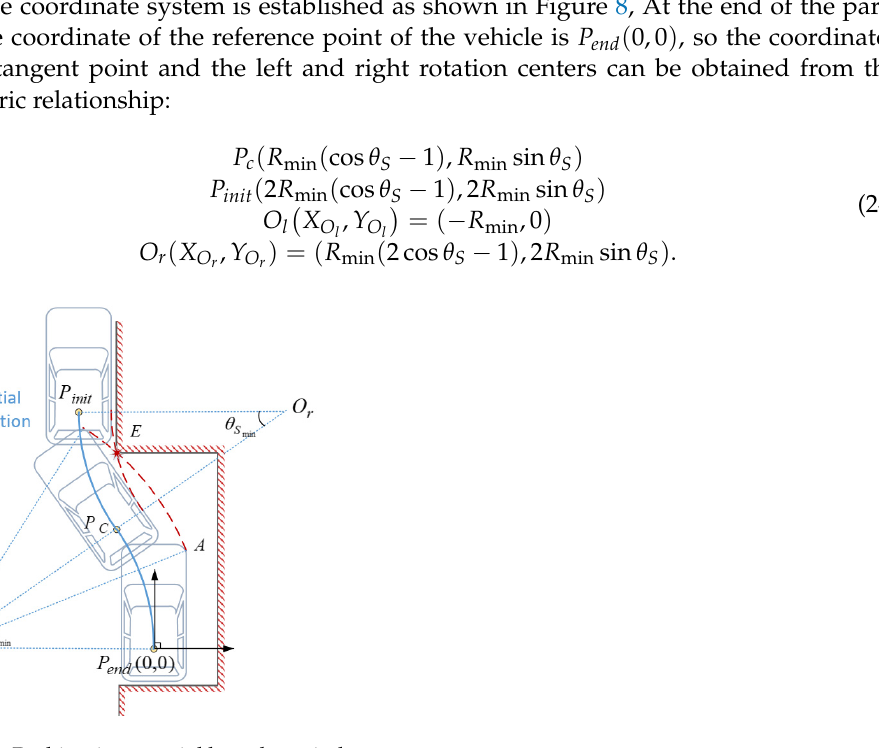
Figure 8. Parking in one trial based on circle arcs. The trajectory equation of the right rear wheel of the vehicle during the second